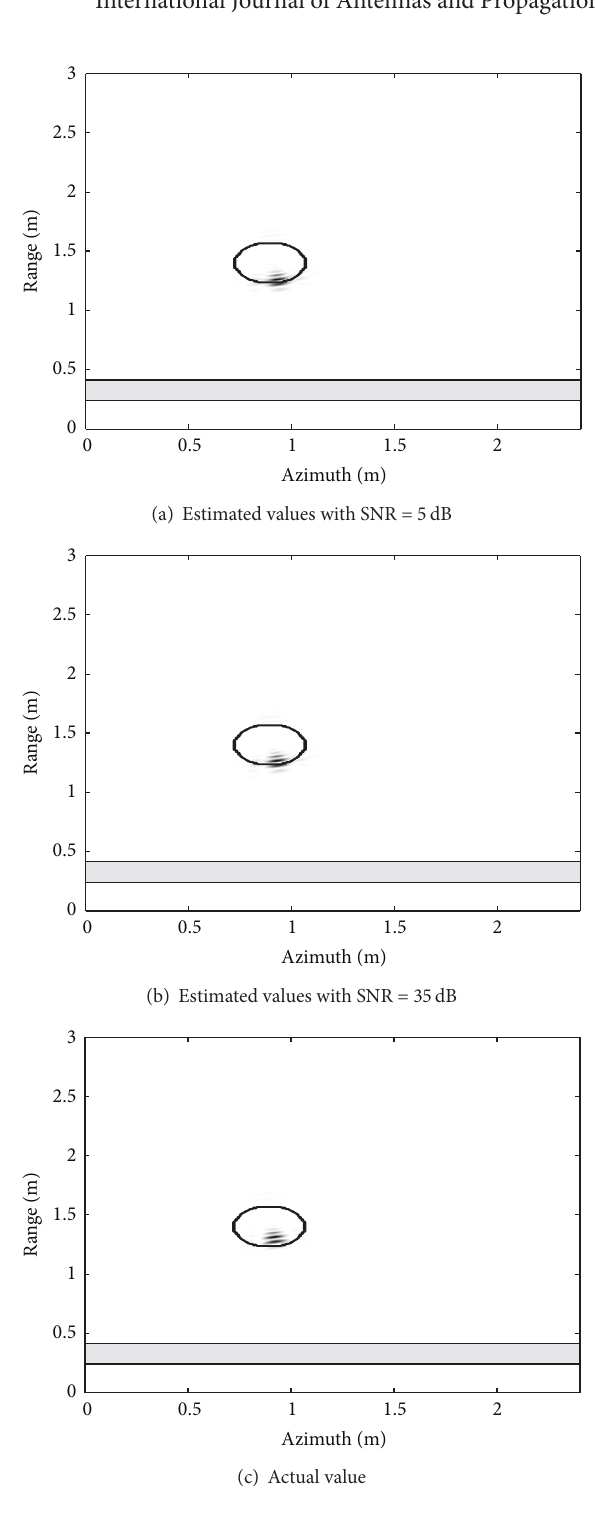
Figure 8: BP images with 𝑟 = 0.17 m according to wall